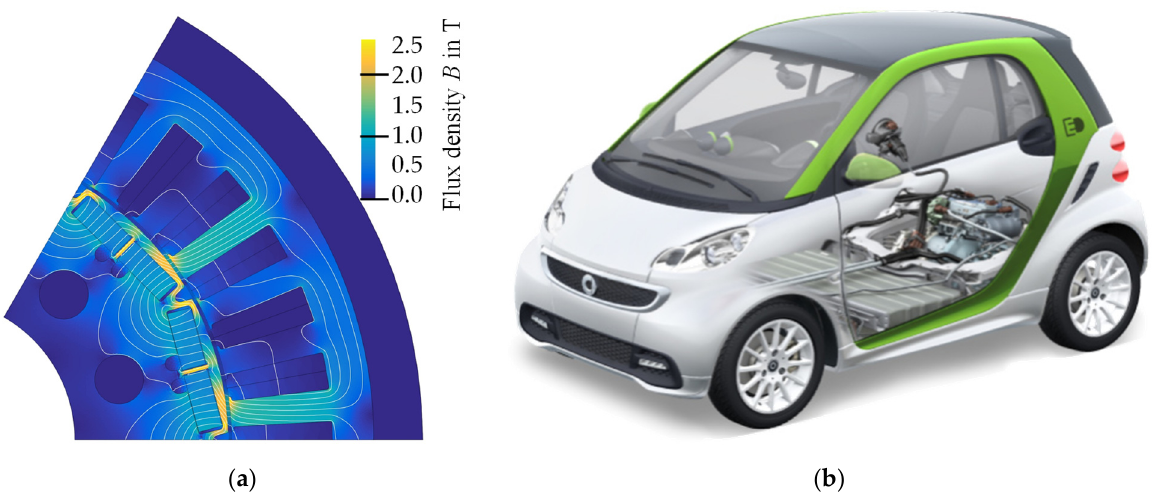
Figure 10. ( a ) One exemplary flux solution of the studied PMSM; ( b ) vehicle in which the studied PMSM is used.